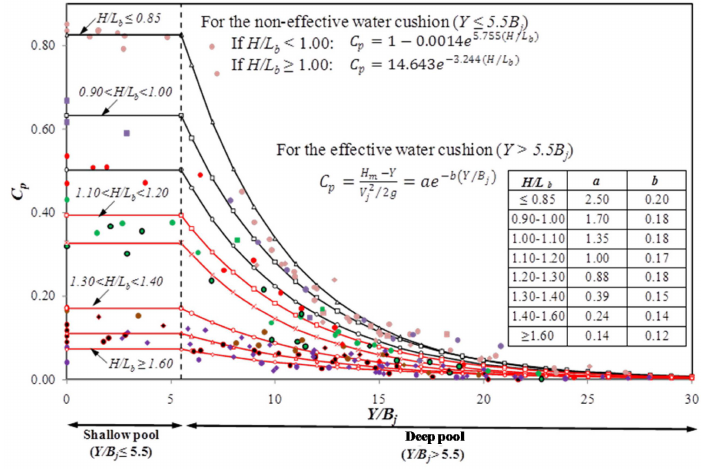
Figure 4. Mean dynamic pressure coefficient ( C p ) for the nappe flow case in function of ratios Y / B j and H / L b (Castillo et al. [27]).